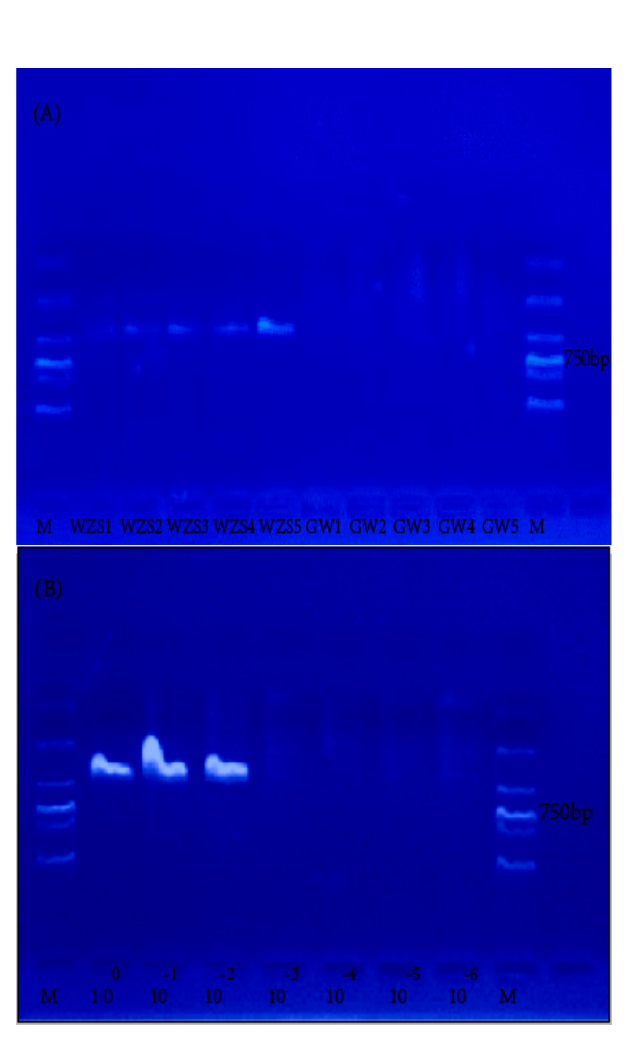
Table 2. Authenticity identification of the crude drug of Wuzhimaotao from different sources. Code